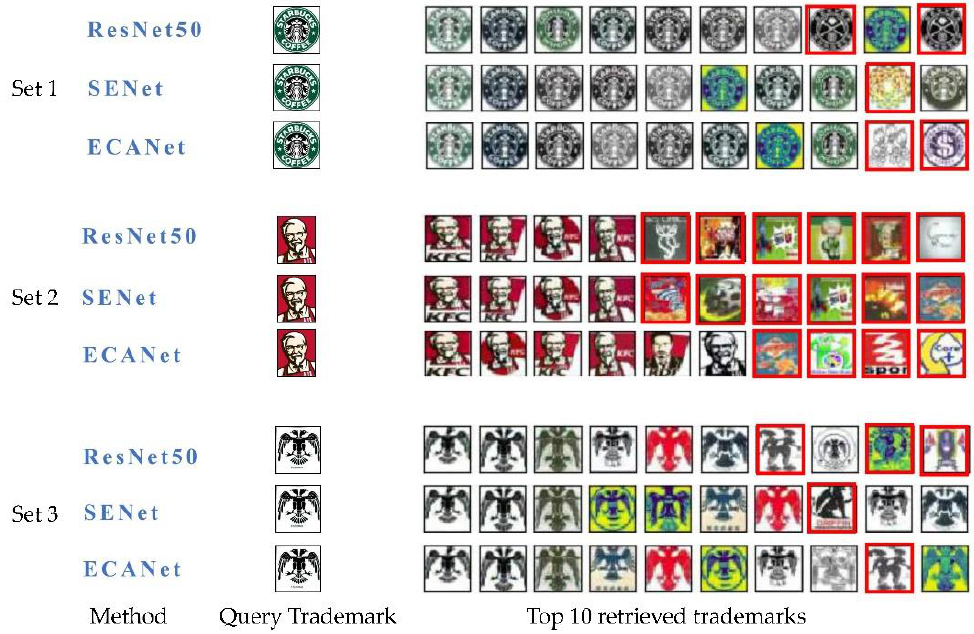
Figure 7. Visualization effect of Convolutional Neural Network (CNN) on trademark image.